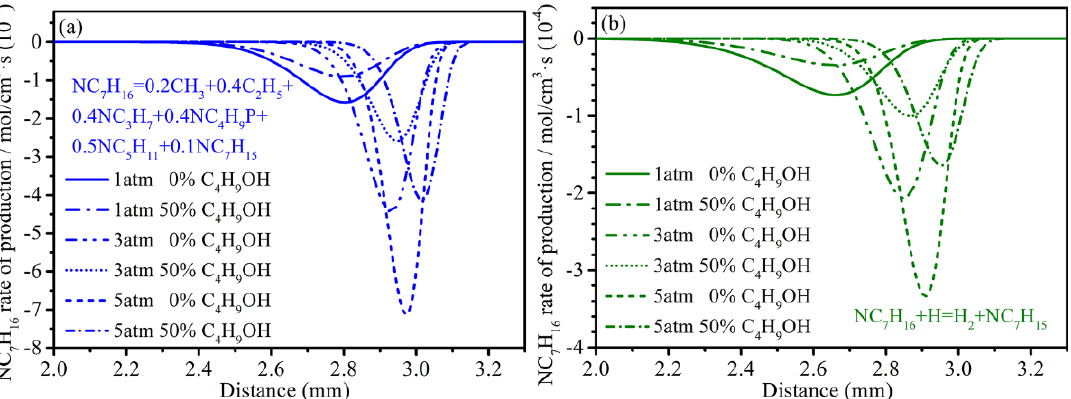
Figure 3. Rate of production of NC 7 H 16 , with different levels of n -butanol at different pressures. ( a ) 742, ( b ) R2584.